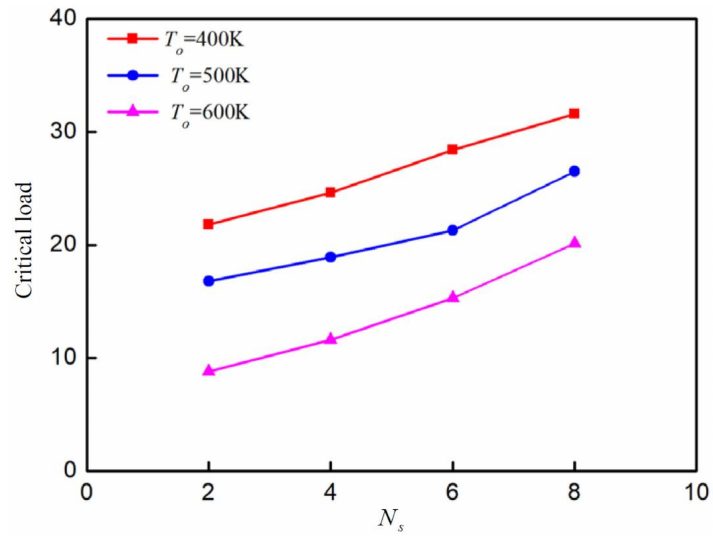
Figure 4. Critical in-plane load versus the number of layers N s with different temperature